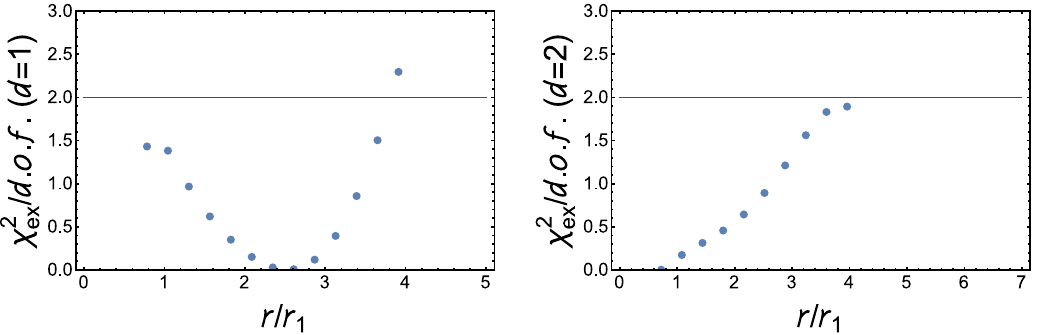
Figure 5 . The reduced (cid:31) 2 in extrapolation [see eq. (D.3) for de(cid:12)nition] for the distances where the continuum limit are taken. As a benchmark, (cid:31) 2 = d : o : f : = 2 is shown by the red line. are extrapolated to the continuum limit smoothly with the reduced (cid:31) 2 less than 2. Only the farthest data of d = 1, which has (cid:31) 2 = d : o : f : > 2, is not adopted as our